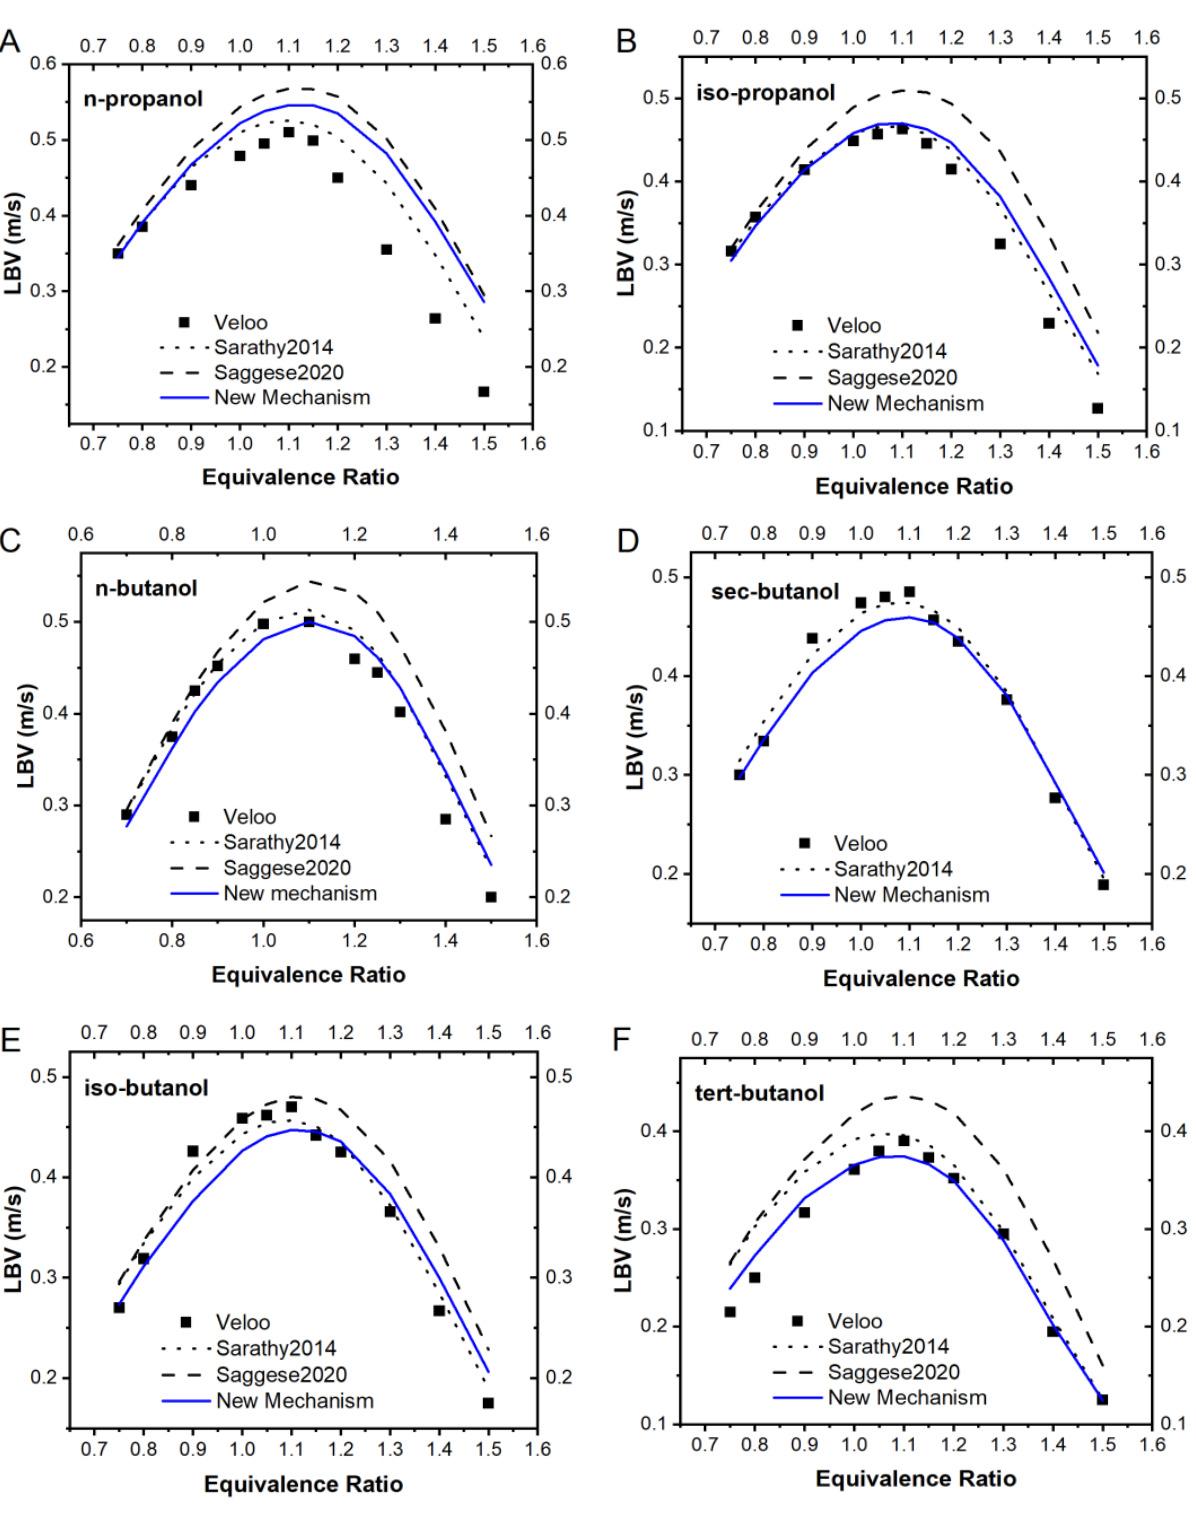
Figure 12. Laminar burning velocity of ( A ) n-propanol, ( B ) iso-propsanol, ( C ) n-butanol, ( D ) sec-butanol, ( E ) iso-butanol, and ( F ) tert-butanol at 343 K in air at P = 1 bar. Symbols represent experimental data from Veloo et al. [34].